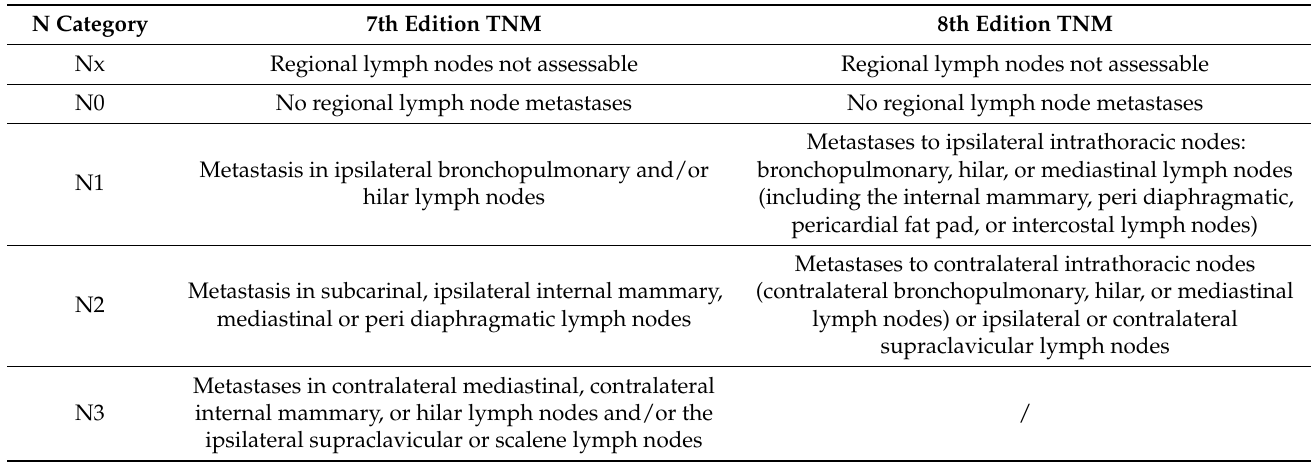
Table 1. N descriptor in MPM by the TNM